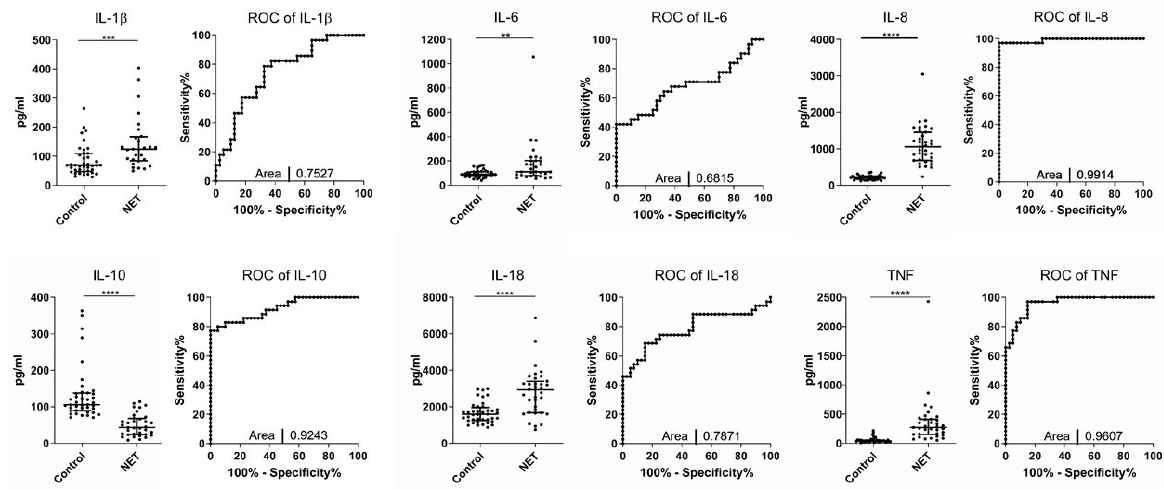
Figure 1 . Inflammatory serum cytokines between healthy controls and NET patient cohort. Analysis of serum cytokines in healthy controls and patients with pancreatic or ileal NETs. Receiver-operating characteristic (ROC)/area under the curve was used to indicate that all evaluated cytokines allow for a discrimination between NET patients and healthy controls (** p < 0.01, *** p < 0.001, **** p < 0.0001). Horizontal bars indicate median and IQR; AUC was automatically calculated using GraphPad Prism.